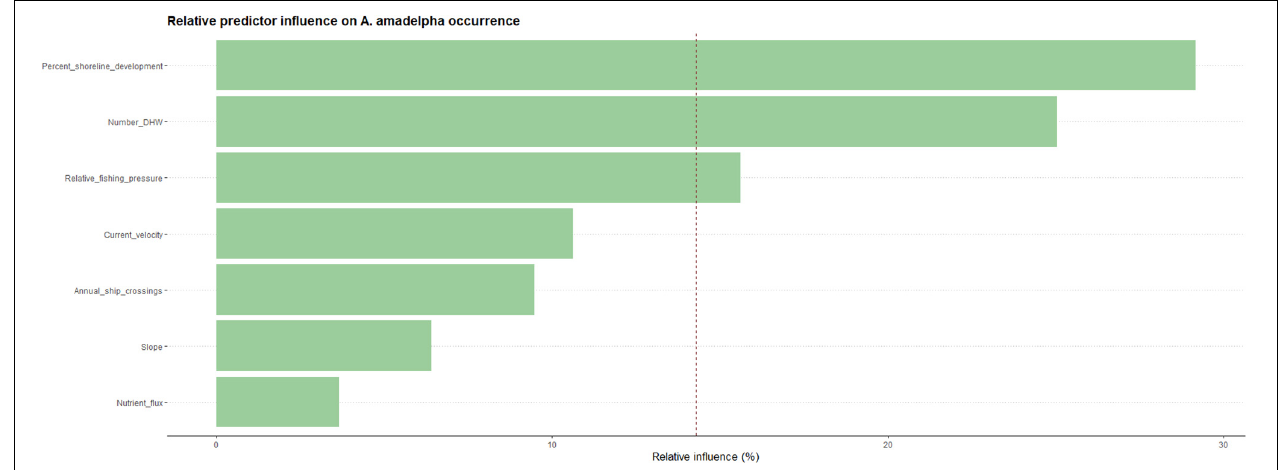
FIGURE 4 | Relative influence of each predictor on A. amadelpha occurrence. The red dashed line indicates the most influential predictors after scaling (i.e., influence percentage divided by number of